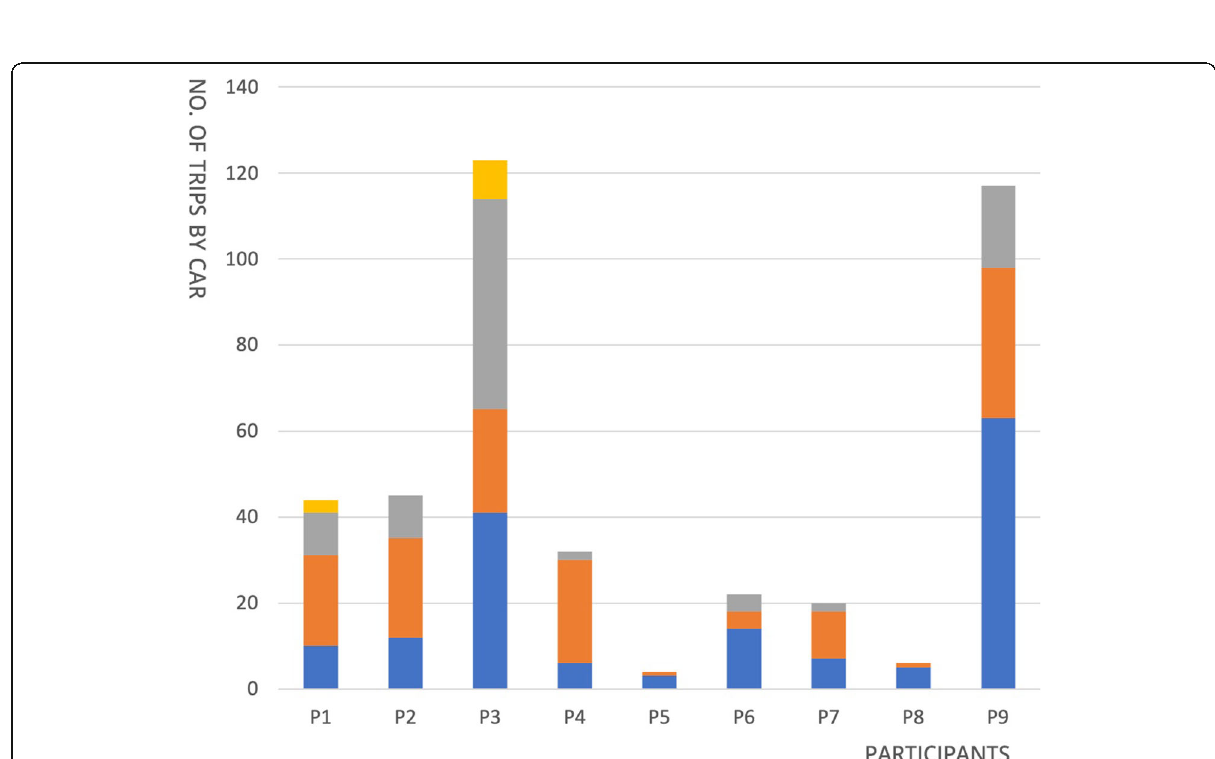
Fig. 5 Number of trips made by car in